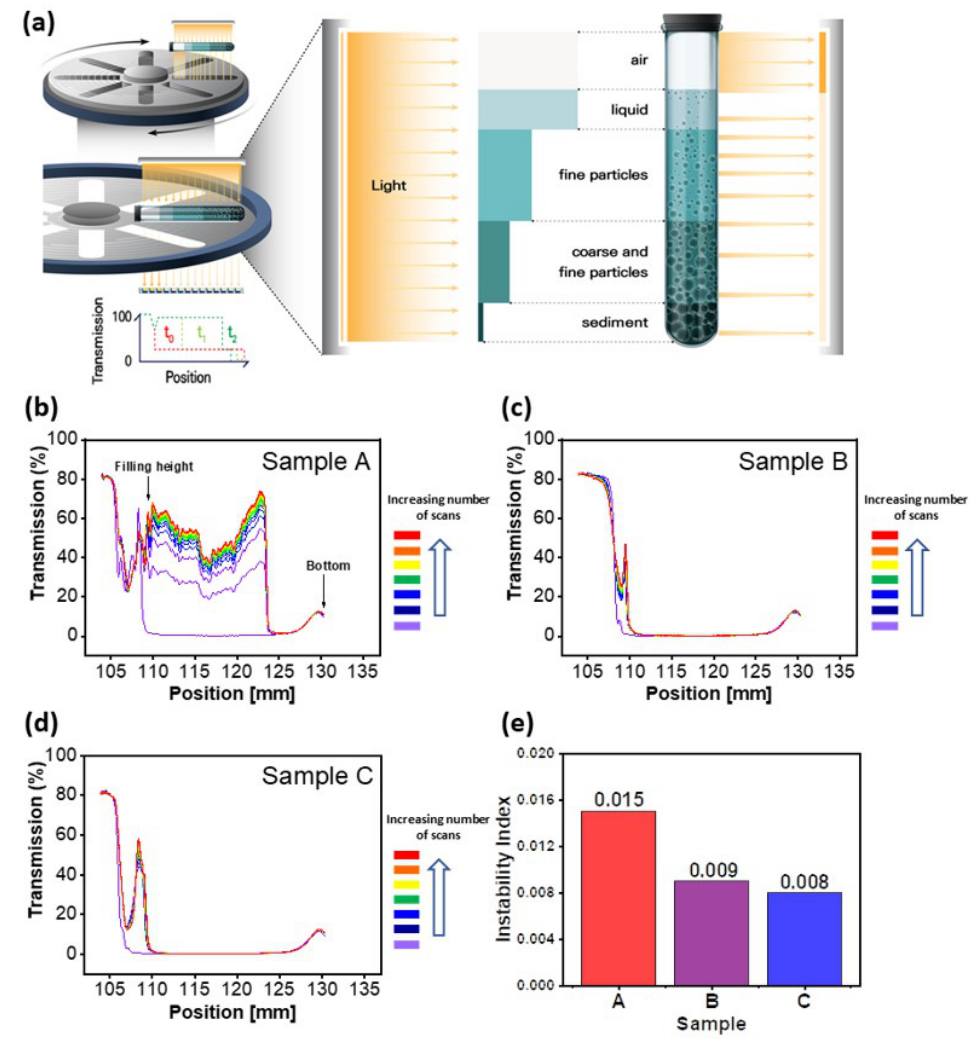
Figure 1. ( a ) Schematic view of dispersion stability analyzer. ( b – d ) Transmission profiles of dispersed carbon nanotube (CNT) samples A, B, and C, which were scanned every 2 h during centrifugation for 40 h. ( e ) Instability index of those